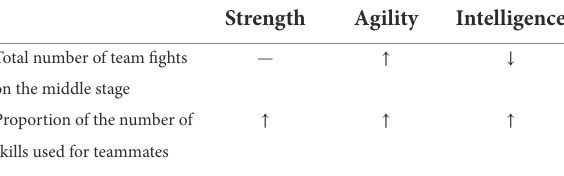
TABLE 7 Changes in backing up behavior-related behavior indicators as players’ self-regulation increased. Strength